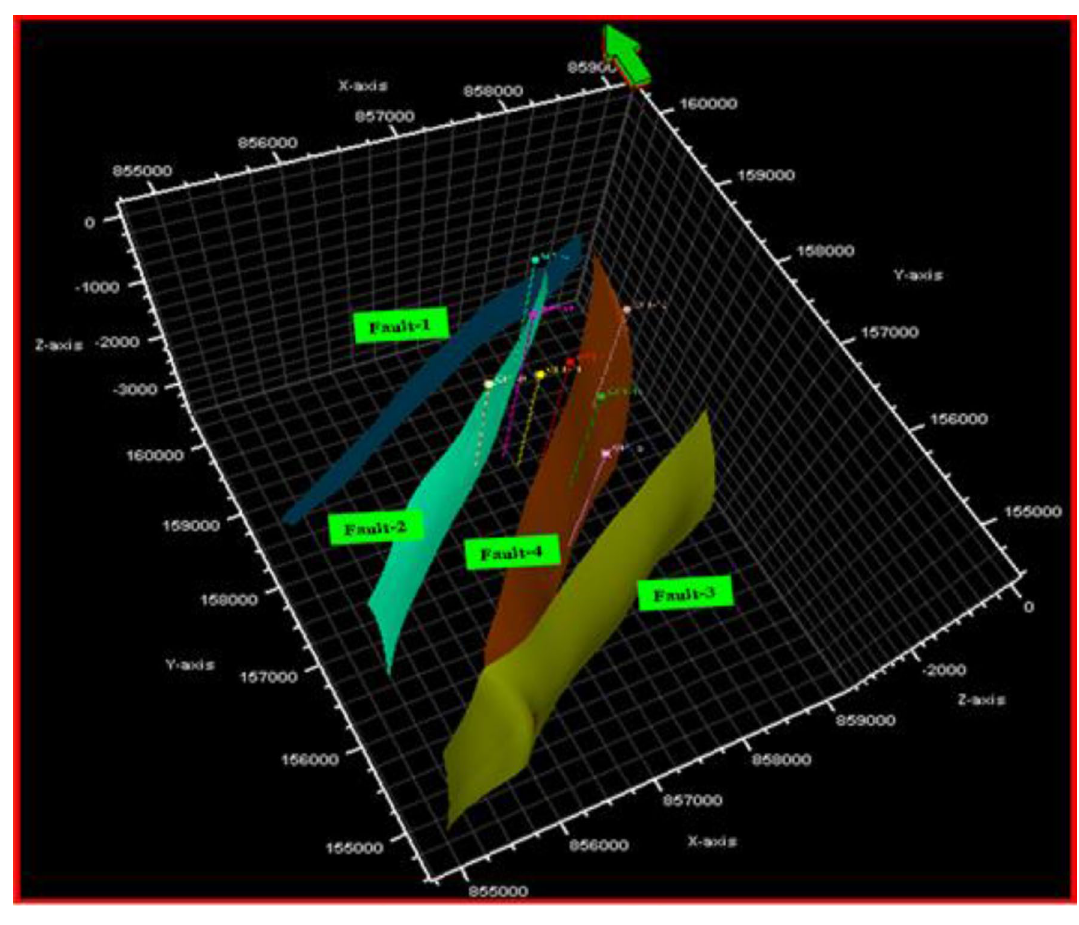
Fig. 12 3D view of the final fault model in the study